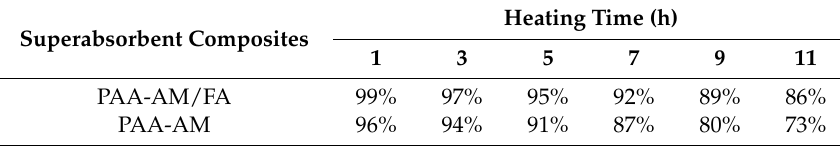
Table 3. The water retention of PAA-AM/FA composite and PAA-AM at 75 ◦ C (wt. %). Superabsorbent Composites